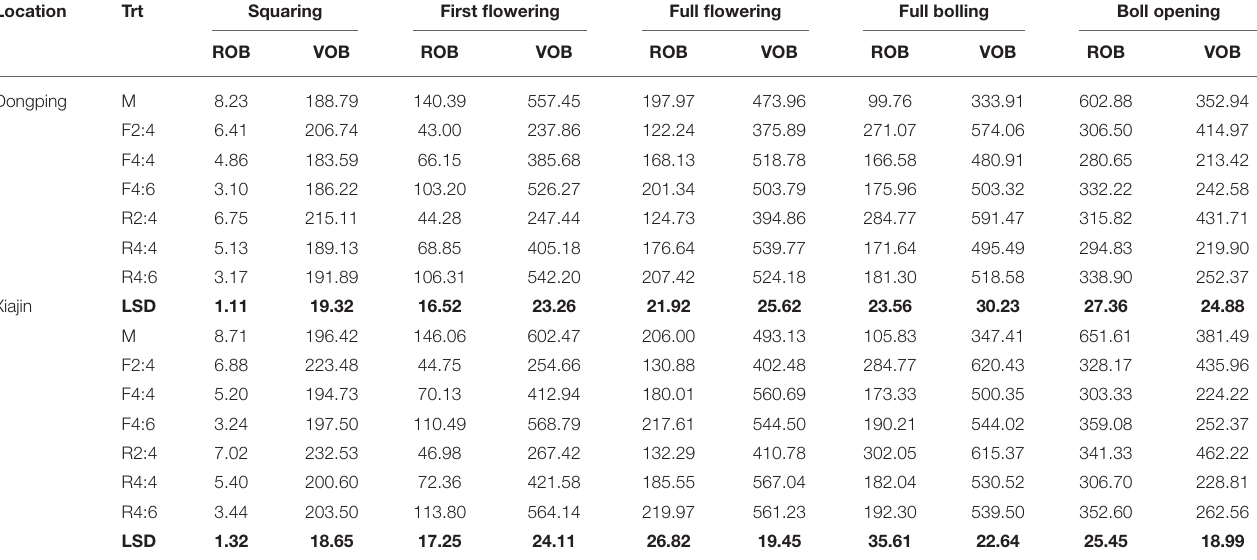
TABLE 3 | Cotton reproductive organs biomass (ROB) and vegetative organs biomass (VOB) accumulation in 2018. Location Trt Squaring First flowering Full flowering Full bolling Boll opening